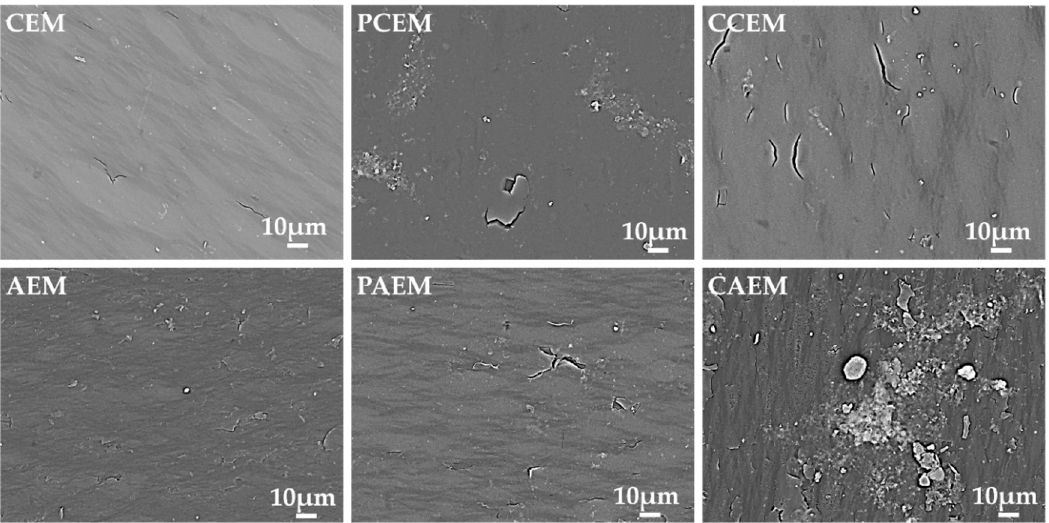
Figure 9. Scanning electron microscopy (SEM) images of cation membranes and anionic membranes after five batch ED and pulse ED runs: CEM and AEM, unused ion- exchange membranes; Cation exchange membranes under pulsed electric field conditions (PCEM) and Anion exchange membranes under pulsed electric field conditions (PAEM), ion exchange membranes used for pulse ED; Cation exchange membranes under conventional electric field conditions (CCEM) and Anion exchange membranes under conventional electric field conditions (CAEM), ion-exchange membranes used for ED.